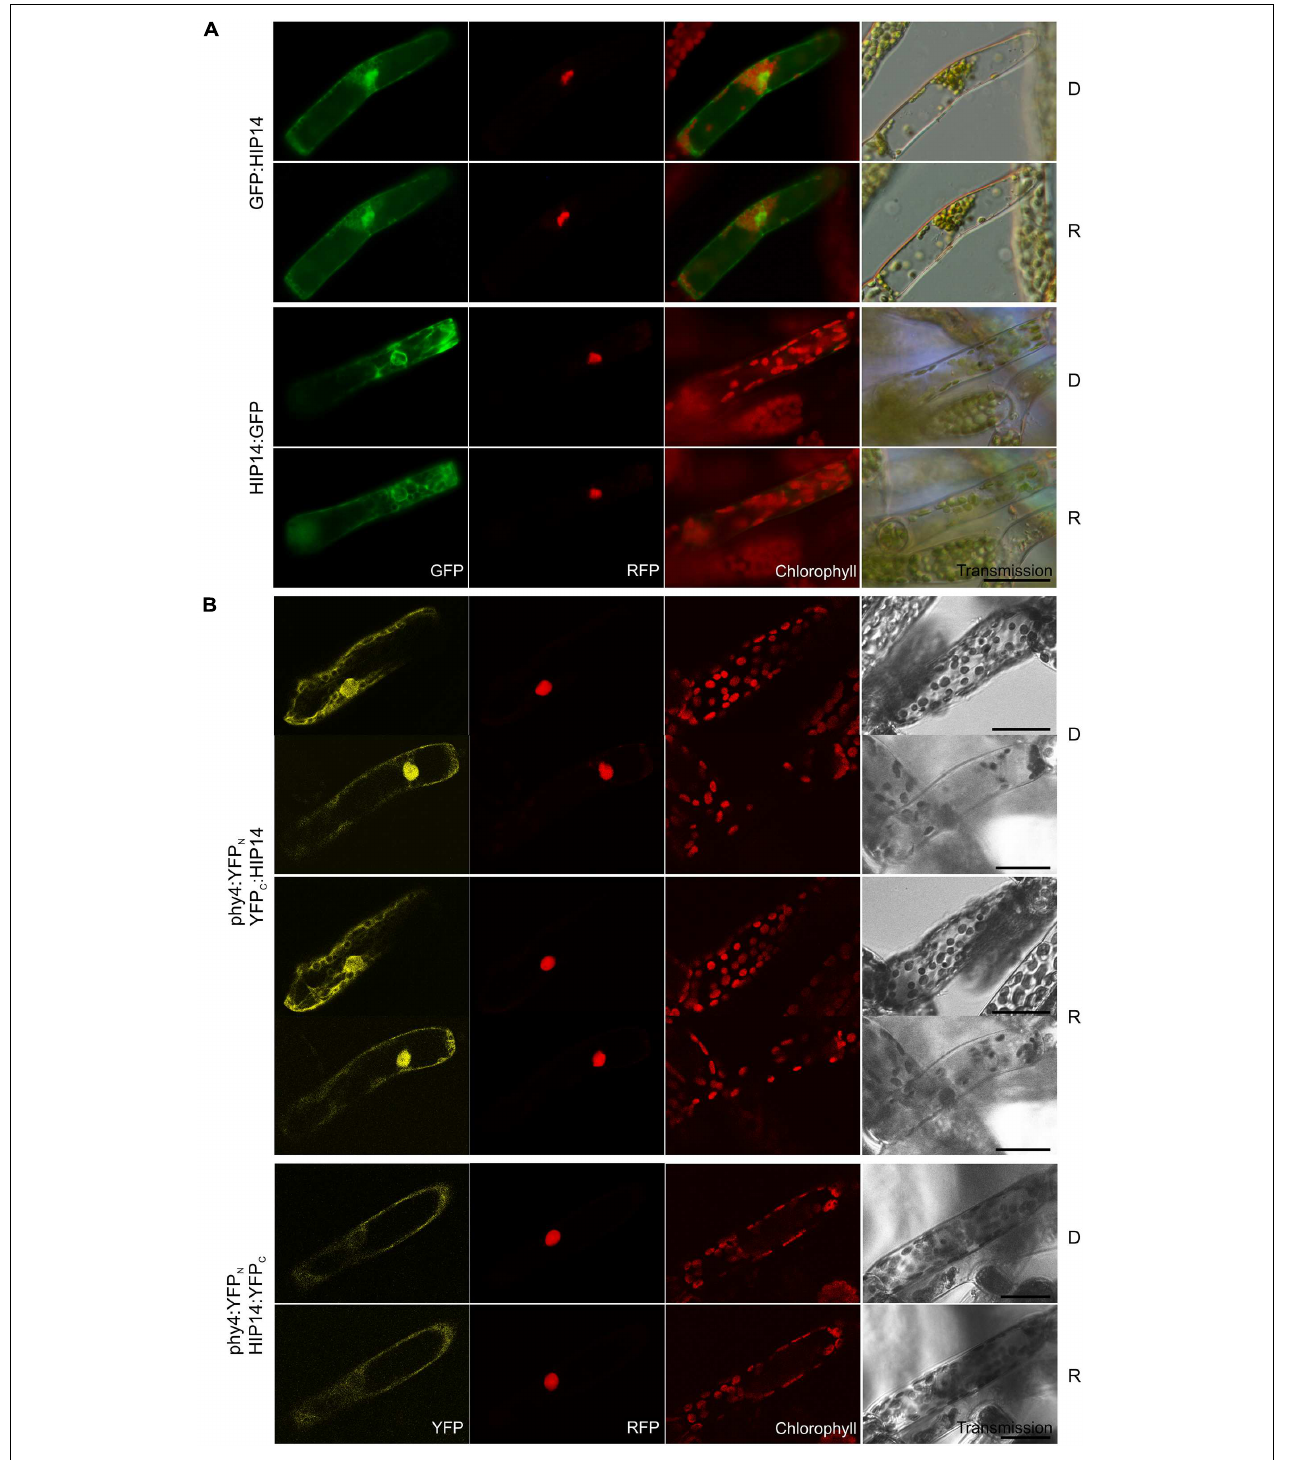
FIGURE 12 | HIP14 (Pp3c3_8540C1.1) intracellular localization (A) and split-YFP-studies of HIP14–phy4 interaction (B) each without (D) and with R pre-treatment (R) using fluorescence- and confocal microscopy, respectively. Overall figure structure is analogous to Figure 1 . (A) GFP:HIP14 (rows 1 and 2) and HIP14:GFP (rows 3 and 4) localized to cytoplasm and nucleus and to cytoplasm and perinuclear region showing a cytoskeleton-like pattern, respectively (column 1, GFP). (B) Corresponding to the Y2H interaction behavior, split-YFP configurations in combination with C-terminally fused phy4 were analyzed: phy4:YFP N –YFP C :HIP14 (rows 1–4; two distinct signal patterns in both conditions) and phy4:YFP N –HIP14:YFP C (rows 5 and 6). All configurations tested yielded significant cytoplasmic or nucleo-cytoplasmic signals (column 1, YFP). Scale bars 30 µ m.